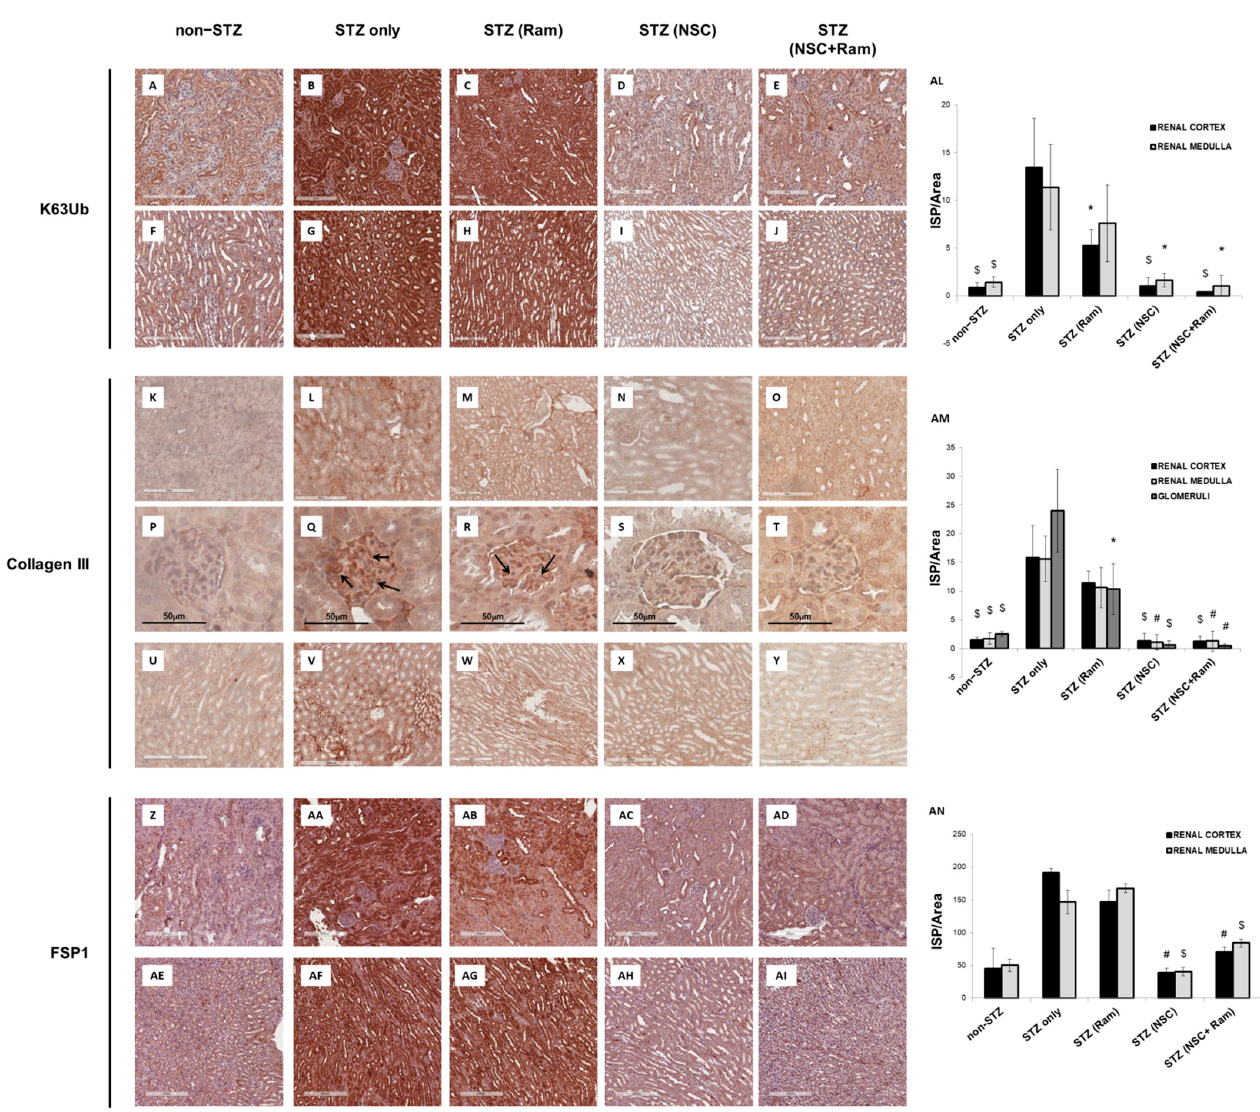
Figure 2. NSC697923, alone and in combination with ramipril, reduced K63-ubiquitination, collagen III expression. and FSP-1 expression in the renal cortex and medulla of STZ-treated DBA/2J mice. ( A – J , AL ). Immunoperoxidase staining against K63-ubiquitinated proteins on renal formalin-fixed paraffin-embedded section of DBA/2J mice. ( K – Y , AM ) Collagen expression evaluated by immunoperoxidase staining against collagen III. Black arrows indicate Collagen III deposits within glomerular capillaries ( Z – AI , AN ). Staining of fibroblasts derived from EMT evaluated by immunoperoxidase staining against FSP-1. All experiments were performed on five different groups of animals, each group including at least four different animals. Non-diabetic animals are indicated as non-STZ; diabetic animals that did not receive any other compound are indicated as STZ-only; diabetic animals treated with either ramipril, NSC697923, or the combination, are indicated respectively as STZ (Ram), STZ (NSC), and STZ (NSC + Ram). Mean intensity of strong positive related to the area analyzed was measured for K63-ubiquitination, collagen III, and FSP-1 immunohistochemistry. Error bars indicate standard deviation. * p < 0.05 vs. STZ only; $ p < 0.005 vs. STZ only; # p < 0.0005 vs. STZ only.